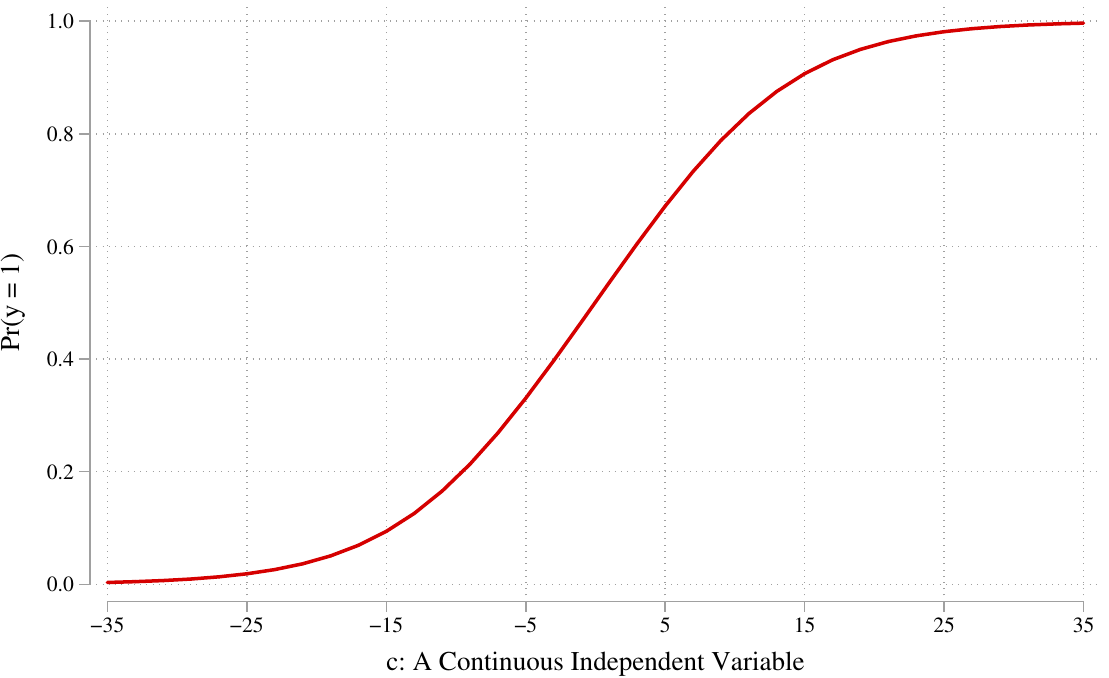
c: A Continuous Independent Variable